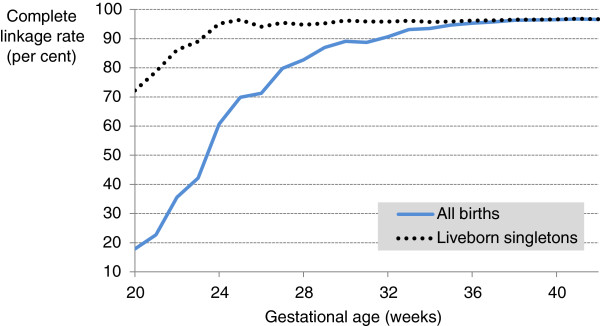
Linkage rate for complete group by gestational age (weeks). Complete linkage rate (number of birth records linked to both a mother and infant hospital admission birth record as a percentage of all birth records) by gestational age for all births (blue line) and liveborn singletons (dotted black line).